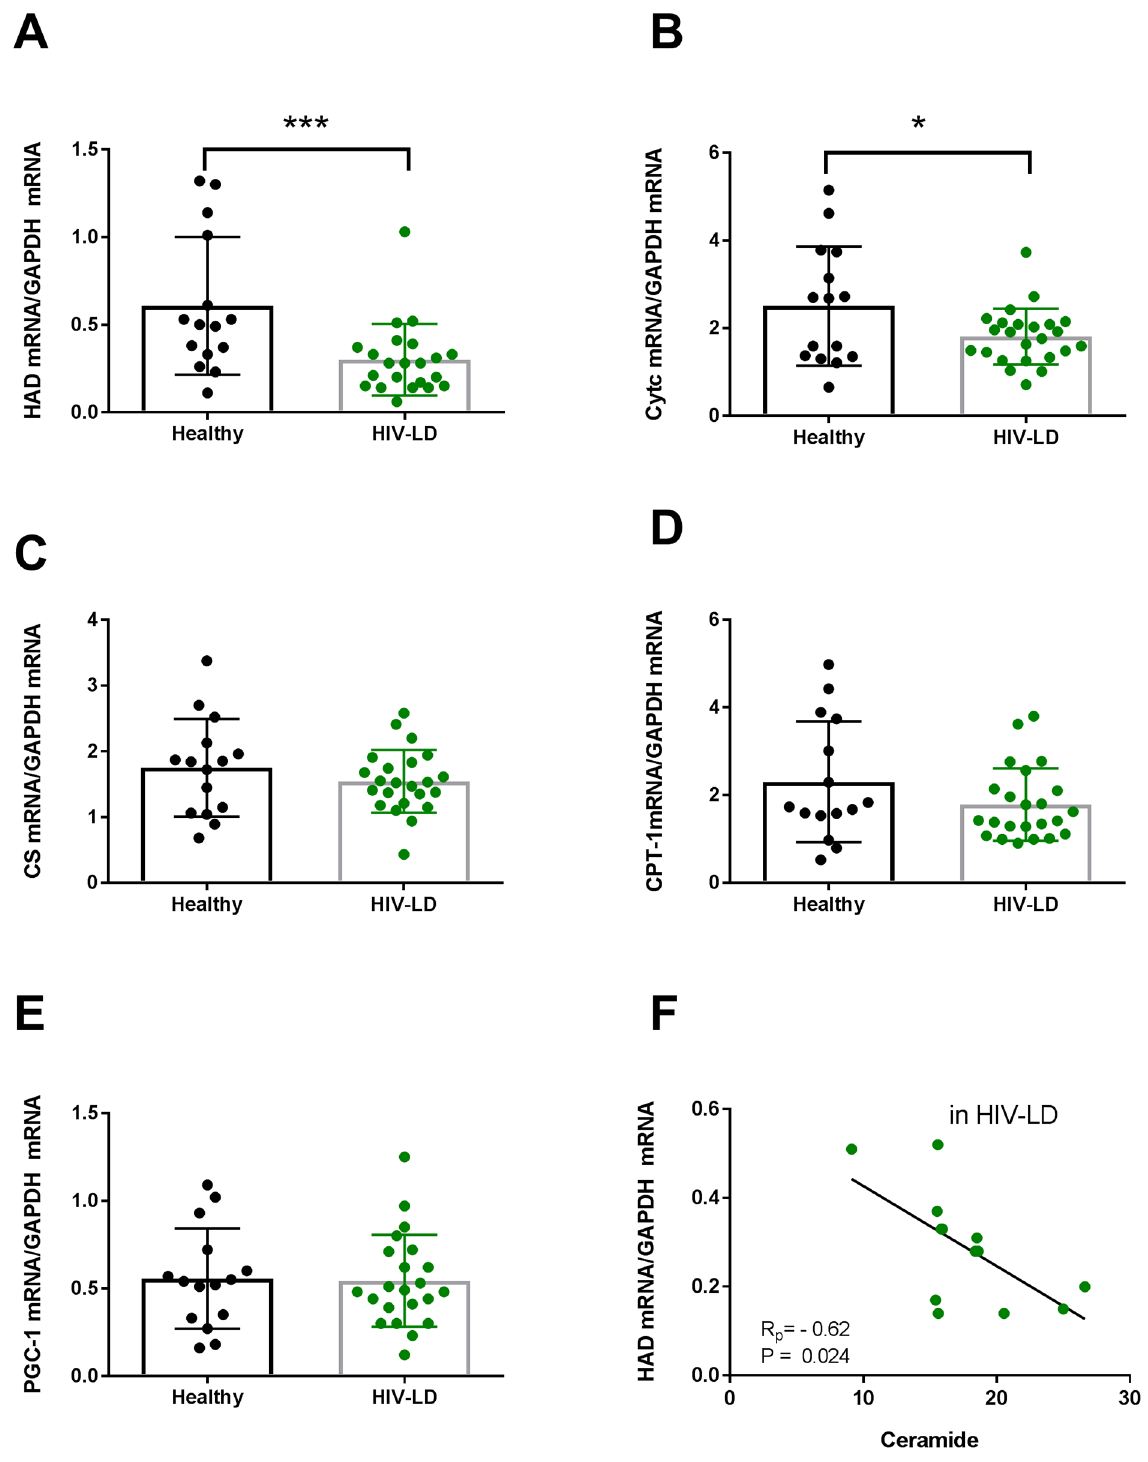
Fig 4. Patients with HIV-Lipodystrophy have reduced levels of HAD mRNA (A) and Cytochrome c mRNA (B) in skeletal muscle, but no difference in citrate synthase mRNA (C), CPT-1 mRNA (D) and PGC-1 mRNA (E). HAD mRNA correlated negatively to the ceramide content (F). The levels of genes were calculated with GAPDH as a housekeeping gene. In the dot plots data for each subjects are given and the line represent means and SD. (cid:3) P < 0.05 and (cid:3)(cid:3)(cid:3) P < 0.001 for healthy vs HIV-lipodystrophy patients. Regressions lines are given HIV-patients